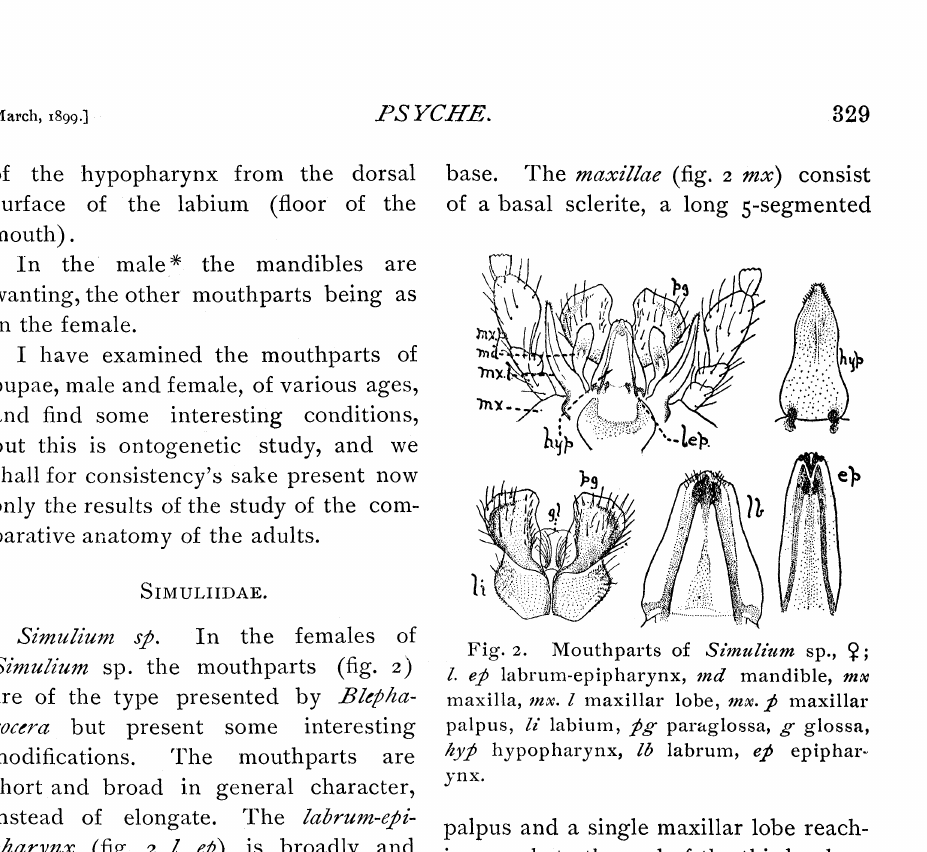
Fig. 2. Mouthparts of Simulium sp., maxilla,